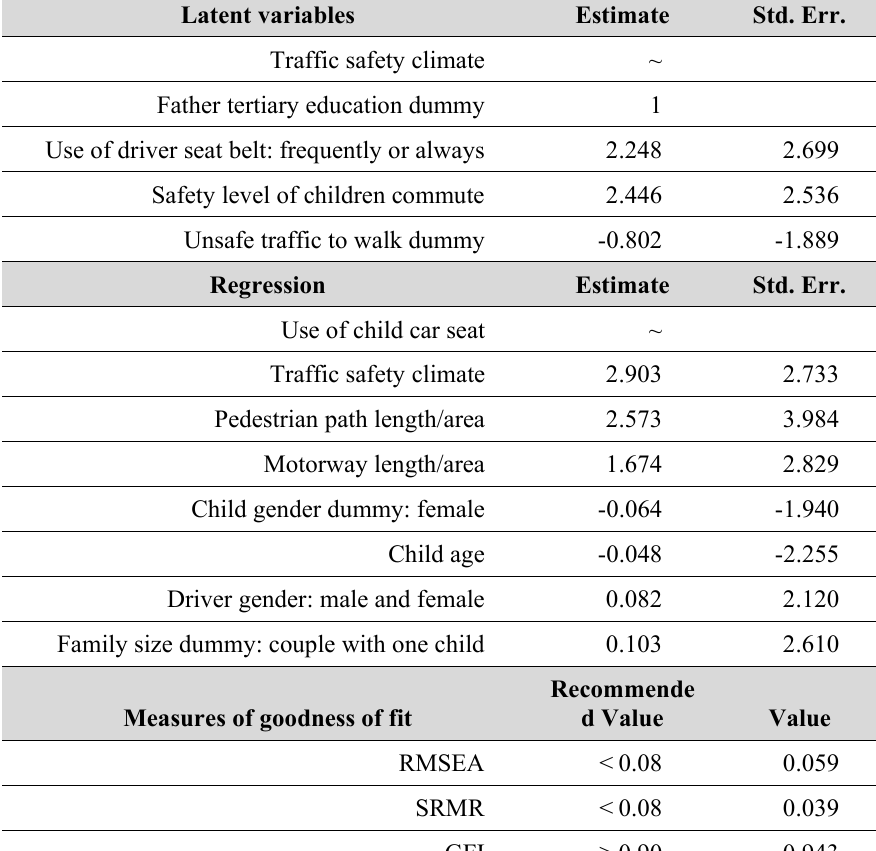
Table 2 Structural equation model estimation